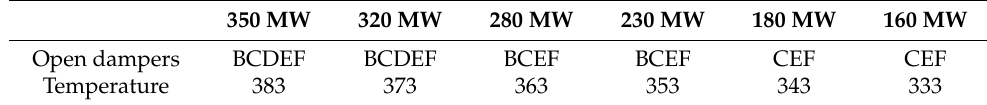
Table 3. The primary air damper opening state and wind temperature table (K).